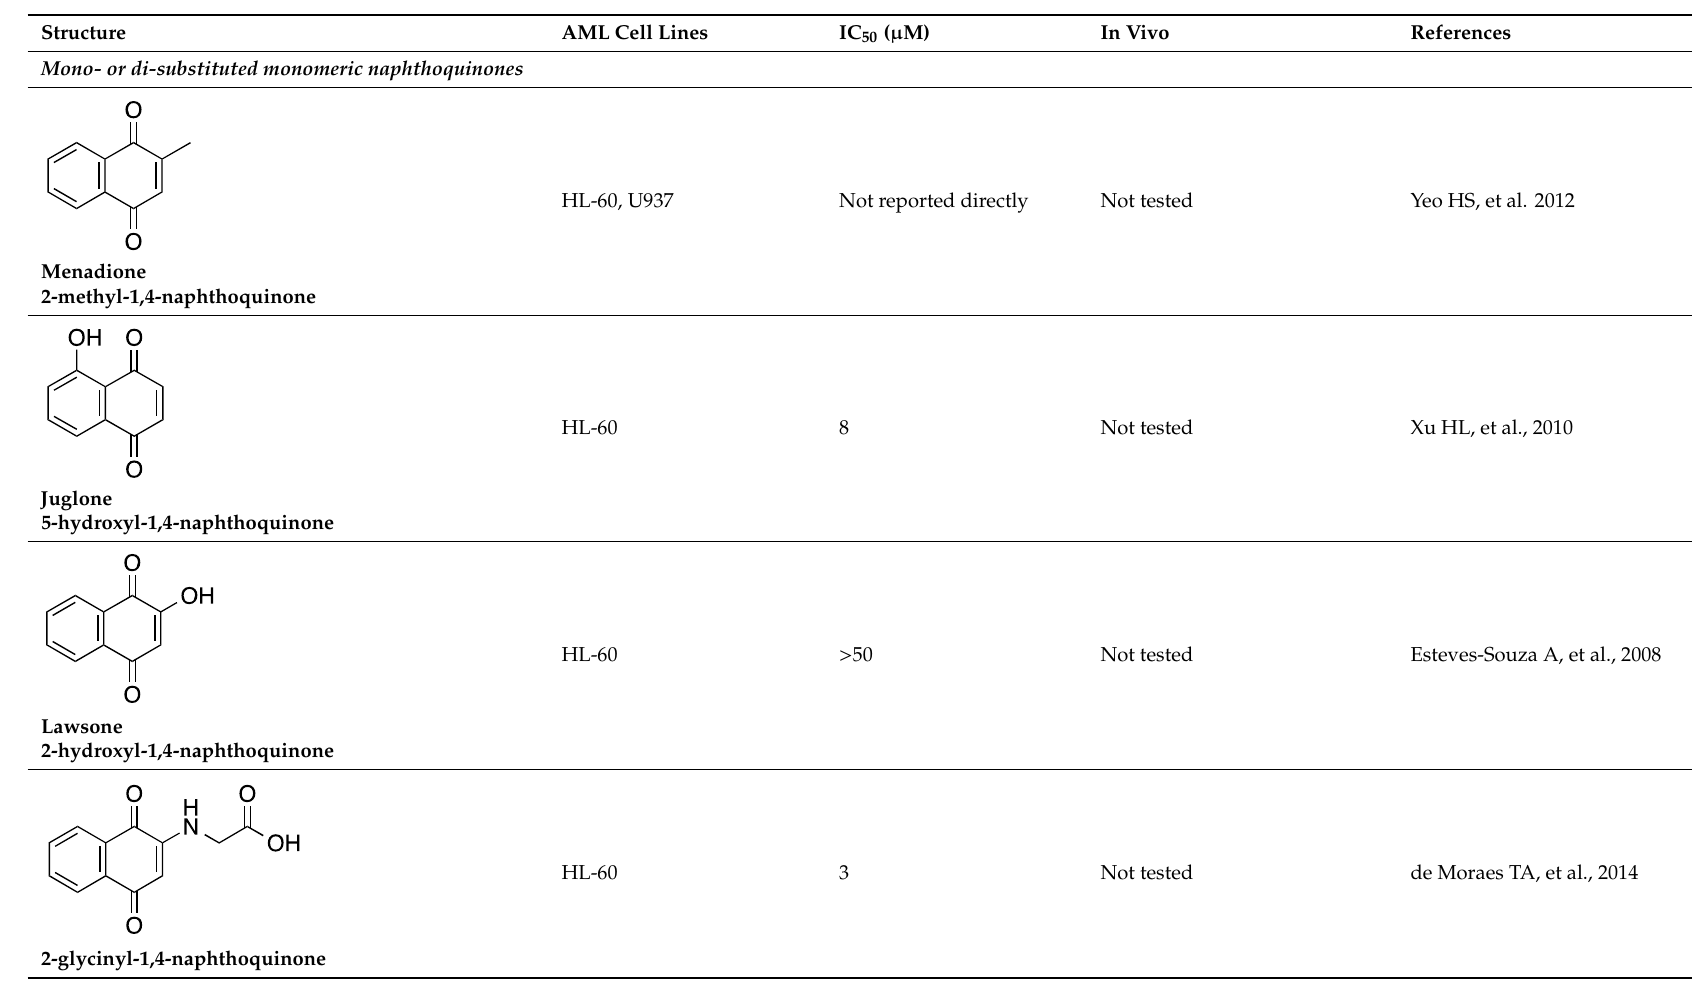
Table 1. Anti-acute myeloid leukemia (AML) naphthoquinones.